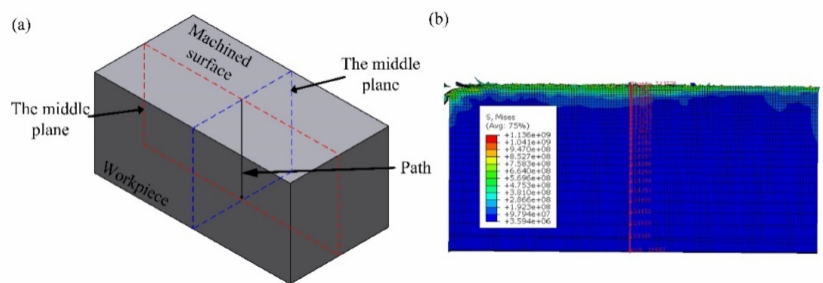
Figure 11. The path of obtained residual stress. ( a ) 3D view ( b ) front